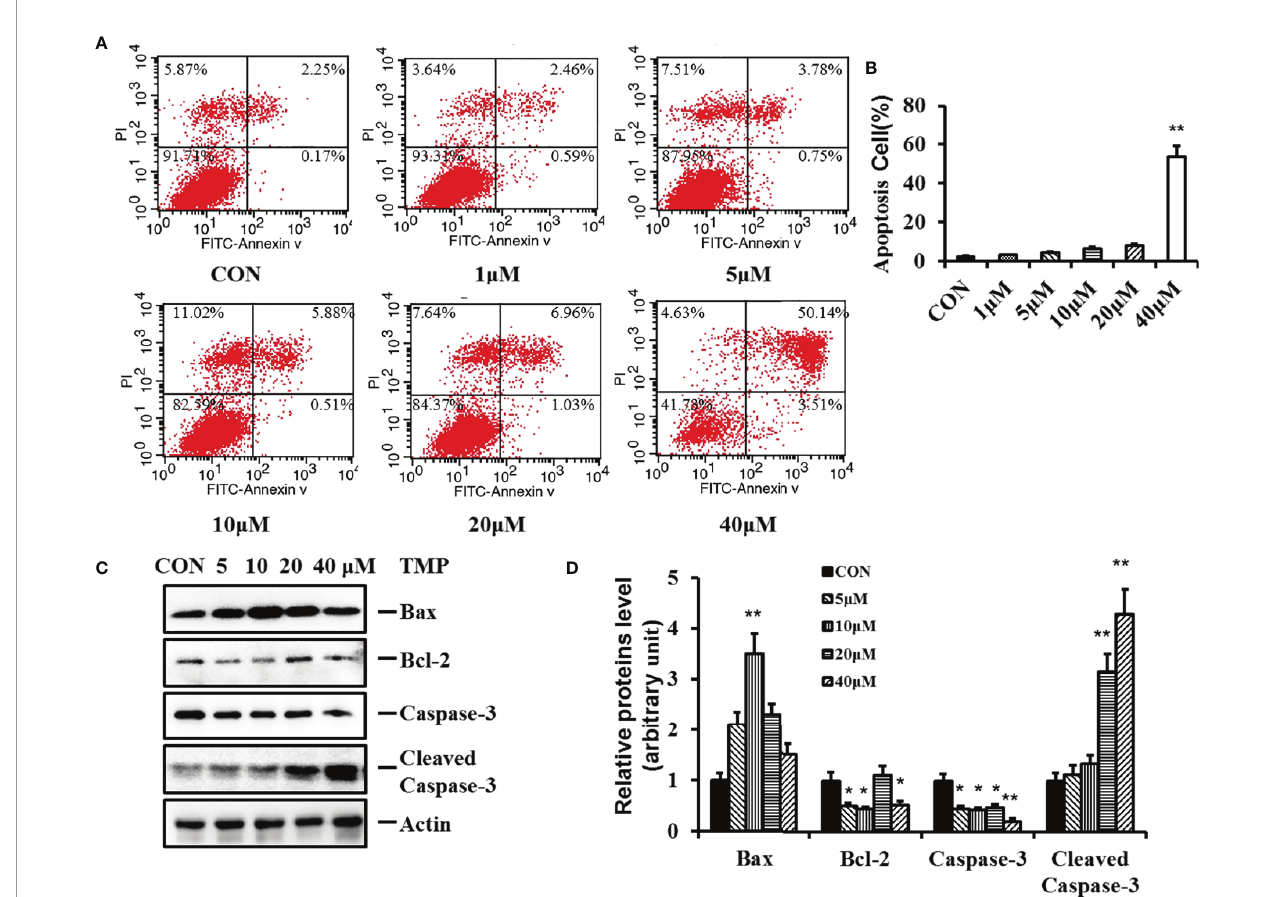
FIGURE 4 | Effect of TMP on apoptosis of HFs and related protein Caspase-3 and Bcl-2. (A) HFs were treated with TMP at 1,5,10,20, and 40 µM for 48 h and cell apoptosis was analyzed by fl ow cytometry. (B) Histogram summarized the results of (A) . The activity of HFs was evaluated by Annexin-V/PI staining; (C) Western blot showed the protein level of Bax, Bcl-2, Caspase-3, and Cleaved Caspase-3 following the TMP treatment for 48 h. Actin served as an equal loading control. (D) Histogram summarized the results of (C) . Error bars represented means ± SD of n = 4. * p < 0.05 and ** p < 0.01 vs. control group. TMP, tetramethylpyrazine; HFs, HS-derived fi